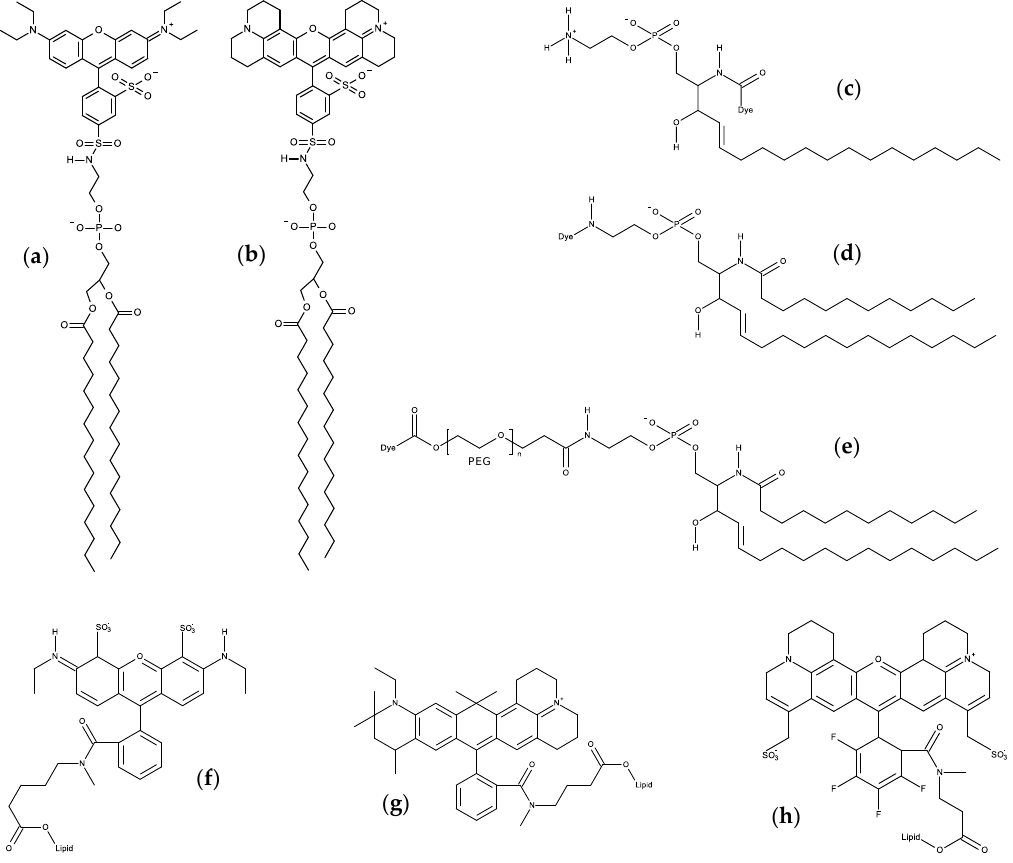
Figure 10. Structures of xanthene-based lipid probes. ( a ) Rhod-DPPE; ( b ) TR − DHPE; ( c – h ) general structures of acyl-chain-labeled ( c ), head-labeled ( d ) and PEG-linked sphingolipids ( e ), with fluorescent tags ATTO532 ( f ), ATTO647N ( g ), or KK114 ( h ).